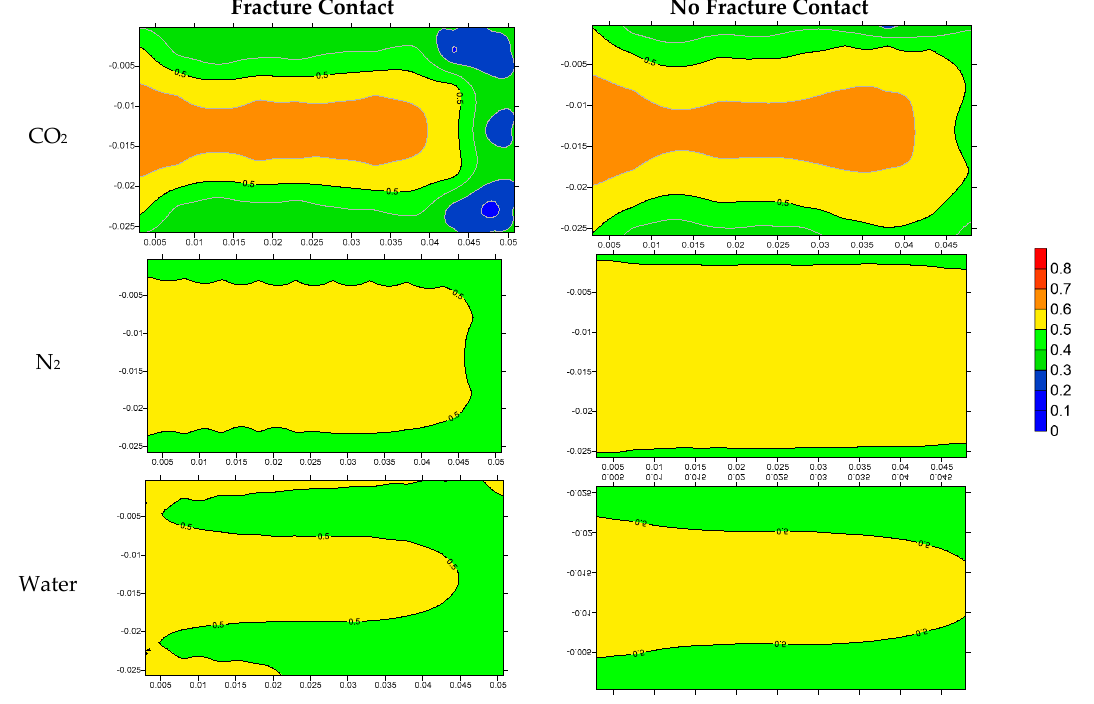
Figure 18. Oil relative permeability of different fluids in Case-4 in the production process (ij profile).